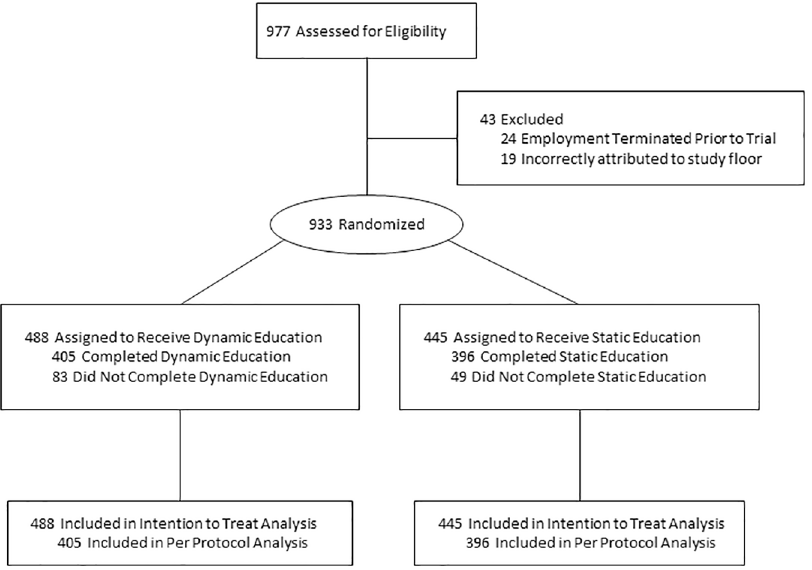
Fig 1. Flow of nurse participants through trial comparing Dynamic education with static education on medication administration practice for venous thromboembolism prevention.